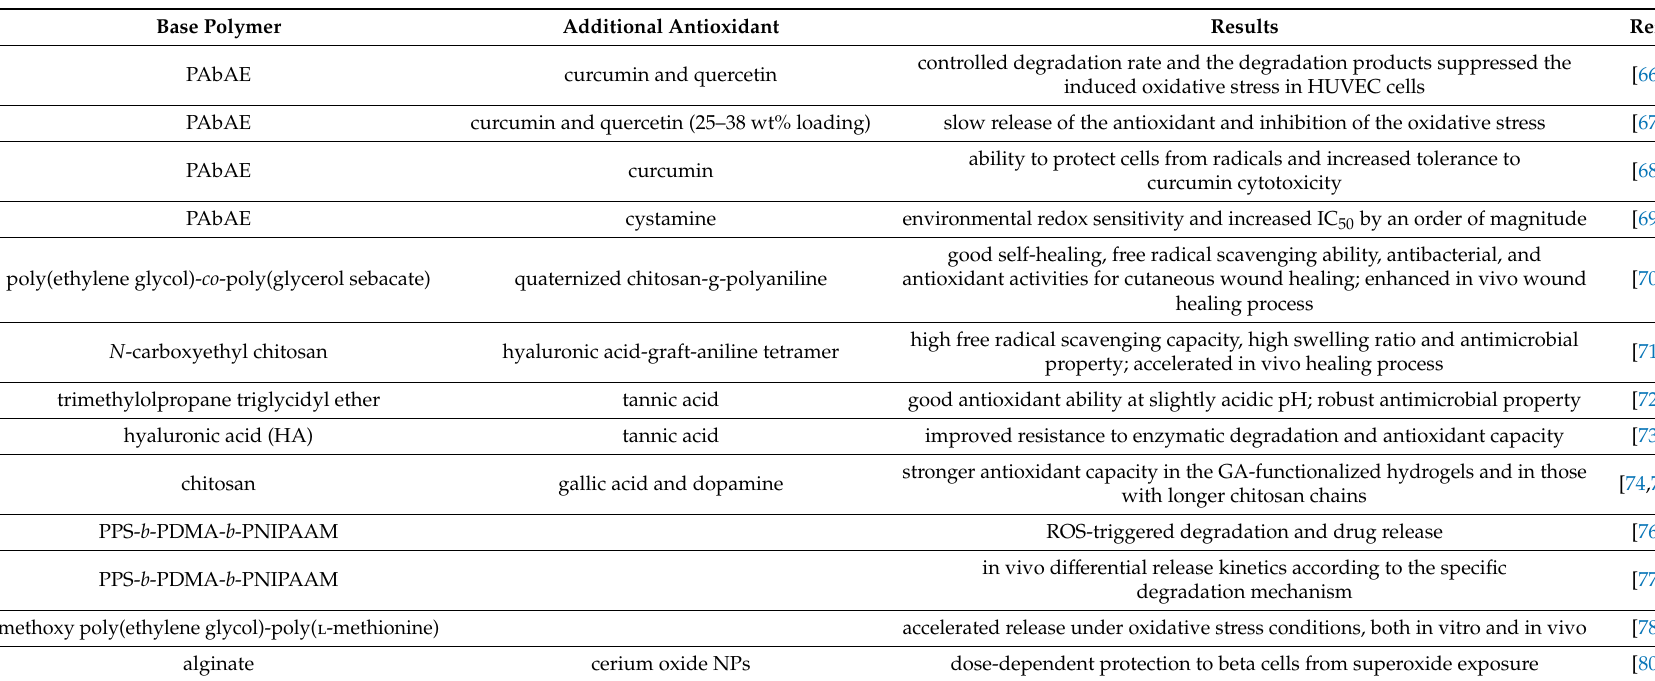
Table 3. Summary of the antioxidant polymeric hydrogels and their e ff ects. ROS: reactive oxygen